Question: According to this chart, does the measure grow or shrink?
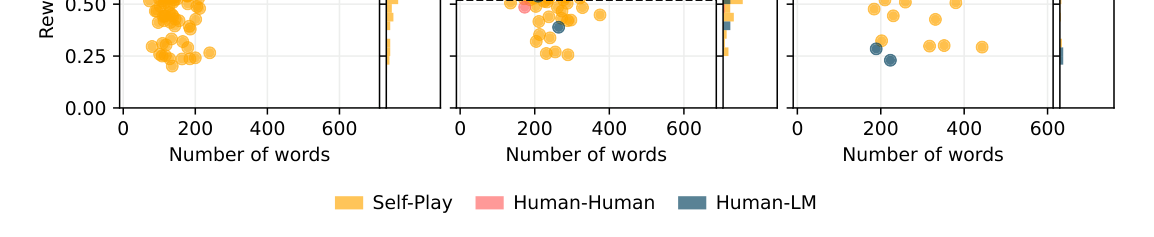
Answer: increasing